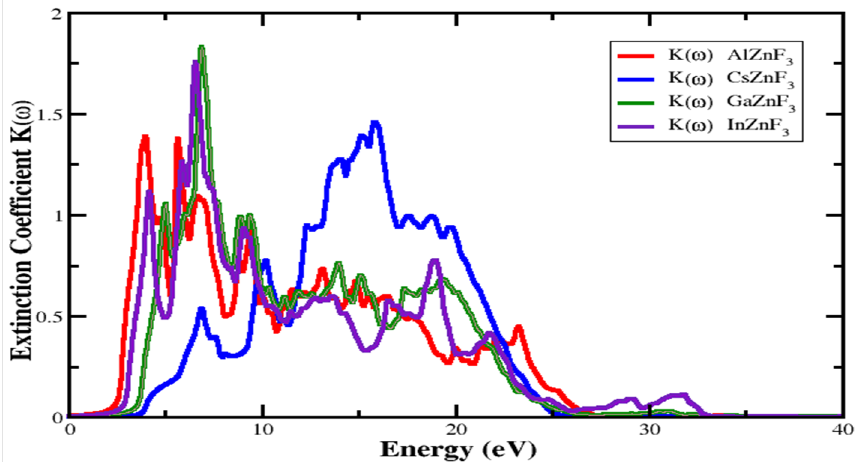
Figure 7. Investigated extinction coefficient K( ω ) of the dielectric function for XZnF 3 (X = Al, Cs, Ga, In).